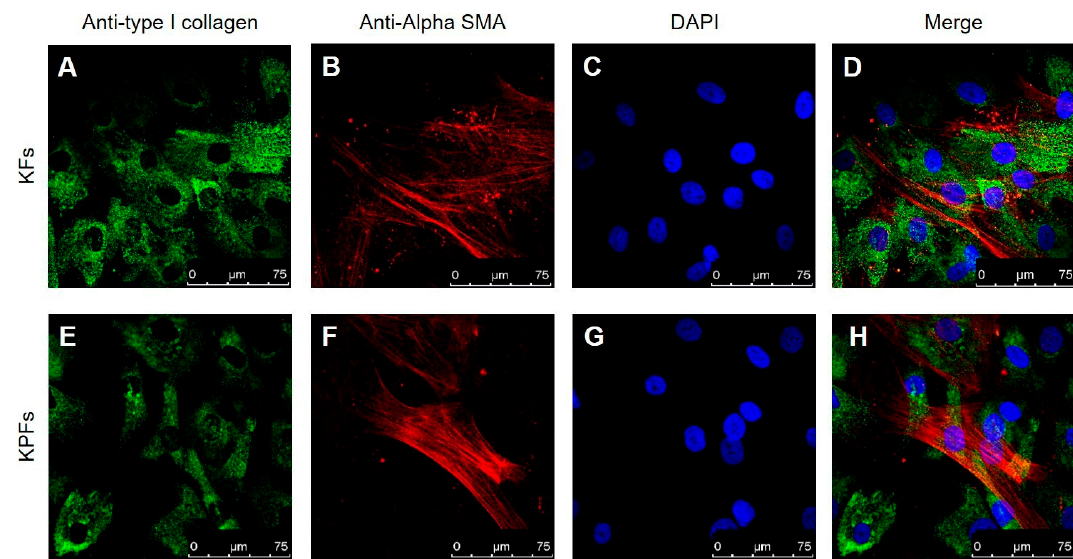
Figure 4. ( A – H ) Myofibroblasts characterization by confocal microscopy in keloid fibroblast cells (KFs) and perilesional fibroblast cells (KPFs). A selective antibody for actin was used and a small population of myofibroblasts was identified both in KFs and in KPFs. ( A , E ) Expression of type I collagen (in green) in KFs and in KPFs, respectively. ( B , F ) Expression of α -SMA (in red) in KFs and in KPFs, respectively. ( C , G ) Cellular nuclei (in blue) labelled with DAPI in KFs and in KPFs, respectively. ( D , H ) Merge of (A,B,C) in KFs and (E,F,G) in KPFs. Scale bar: 75 µm.